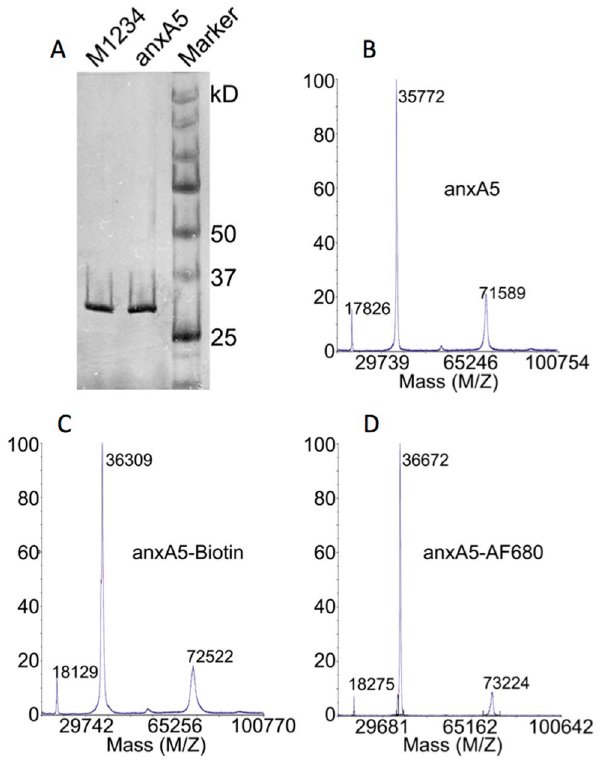
Figure 1. Analyses of purity of anxA5 and M1234, and stoichiometry of anxA5-biotin and anxA5-AF680. (A) 50 ng purified anxA5 and M1234 were run on an SDS-PAGE. The proteins were visualized by silver staining. (B) Maldi TOF/TOF spectrum of purified anxA5 showing a peak of the monomer at 35772 Da, the dimer at 71589 Da and the double protonated peak at 17826 Da. (C) Maldi TOF/ TOF spectrum of anxA5 labeled with maleimide-biotin showing a peak at 36309 Da. Maleimide-biotin labeling resulted in a Mw increase of 6 540 Da indicating 1:1 stoichiometry. (D) Maldi TOF/TOF spectrum of anxA5 labeled with maleimide-AF680 showing a peak at 36672 Da. Maleimide-AF680 labeling resulted in a Mw increase of 6 900 Da indicating 1:1 stoichiometry. Comparable results were obtained with